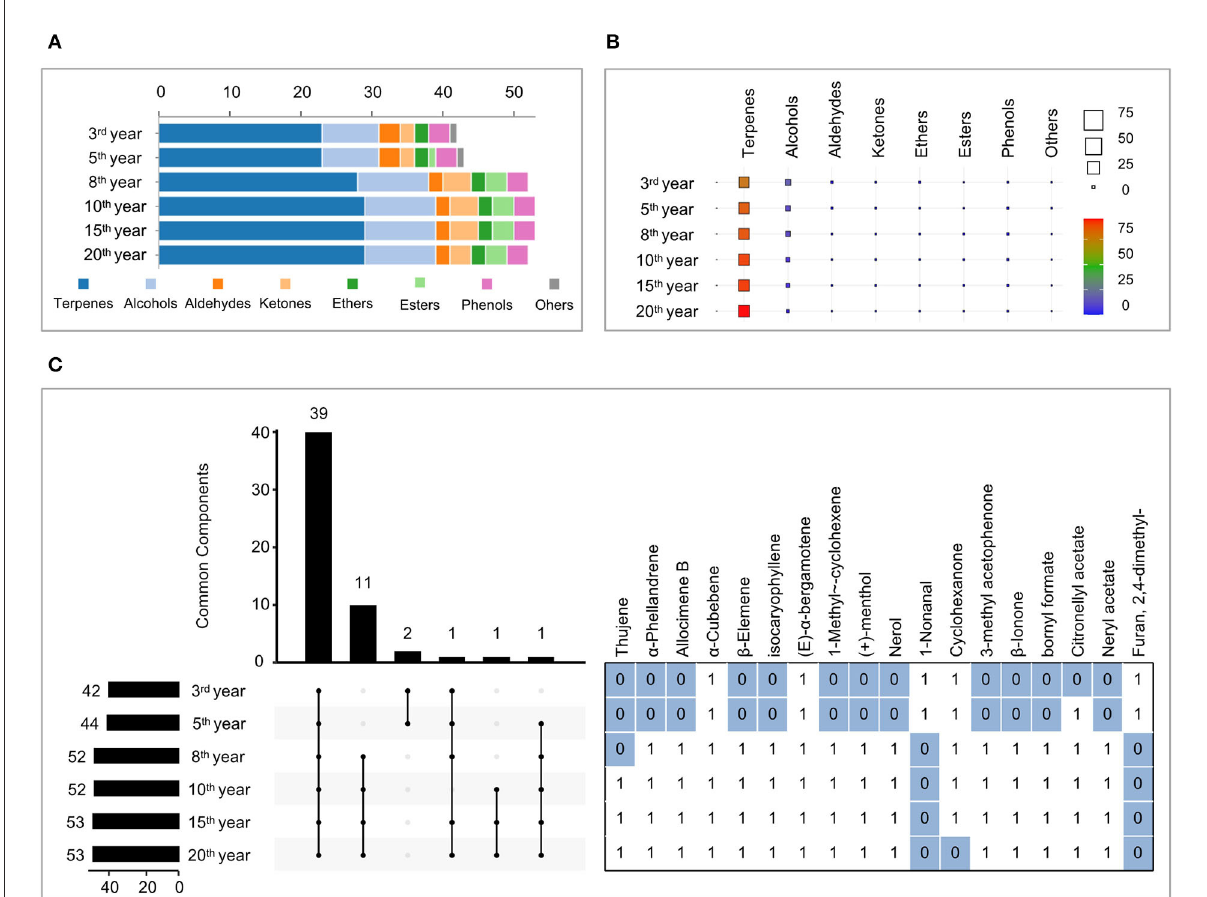
FIGURE2 Composition, content, and commonality of volatile compounds of Laoxianghuang in different fermentation years. (A) A number of terpenes, alcohols, aldehydes, ketones, ethers, esters, phenols, and others in Laoxianghuang. (B) Total relative contents of volatiles in Laoxianghuang for the eight chemical categories. (C) UpSet plot showing the co-occurrence of volatile components in Laoxianghuang at different fermentation times. The total size of each set is represented by the bar plot on the left. Each possible intersection is represented by the bottom plot, and their occurrence is shown on the top bar plot. Detailed table with the frequency of presence of volatile components: presence is indicated by 1, absence by 0. Only components with differences are listed. The other 39 components not listed are present at different times (i.e., all are indicated by 1); these include α -pinene, camphene, β -pinene, myrcene, terpinolene, cymene, limonene, ocimene, γ -terpinene, α -cubebene, (E)- α -bergamotene, β -caryophyllene, α -humulene, (E)- β -farnesene, β -santalene, γ -muurolene, germacrene B, isoledene, α -muurolene, (Z)- α -bisabolene, β -bisabolene, γ -cadinene, δ -cadinene, fenchol, 1-terpinenol, β -terpinenol, dl-isoborneol, borneol, terpinen-4-ol, α -terpineol, γ -terpineol, 2-furaldehyde, 5-methylfurfural, D ( + )-carvone, N-octyl ether, anethole, thymol, chlorothymol, and